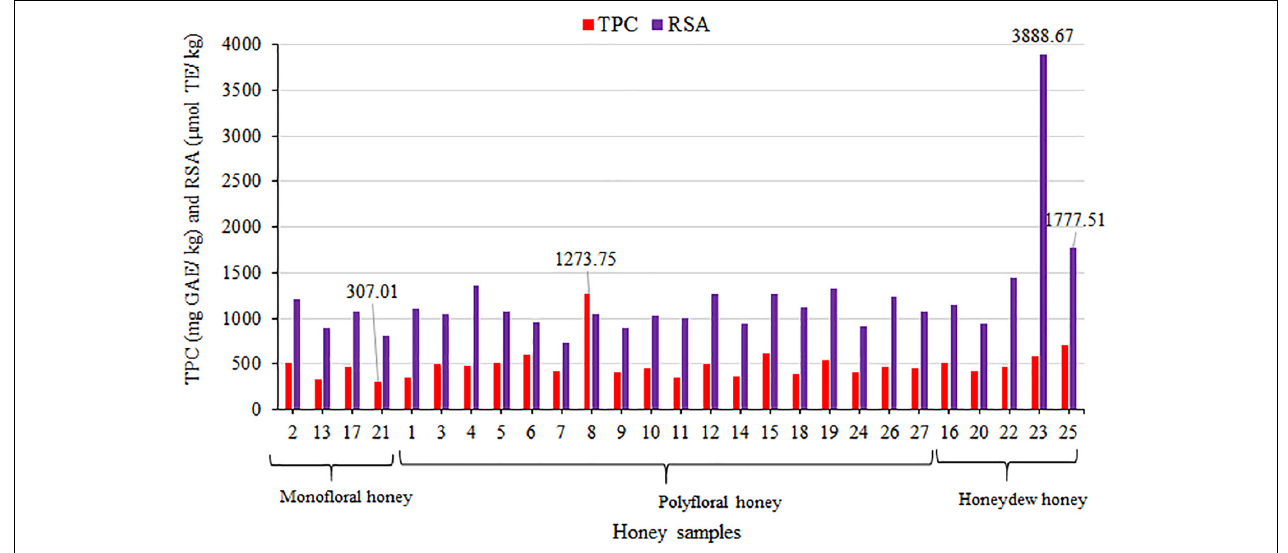
FIGURE 2 | Distribution of the TPC (mg GAE/kg) and RSA ( µ mol TE/kg) in the analyzed honey samples from the Tara Mountain region in Serbia.